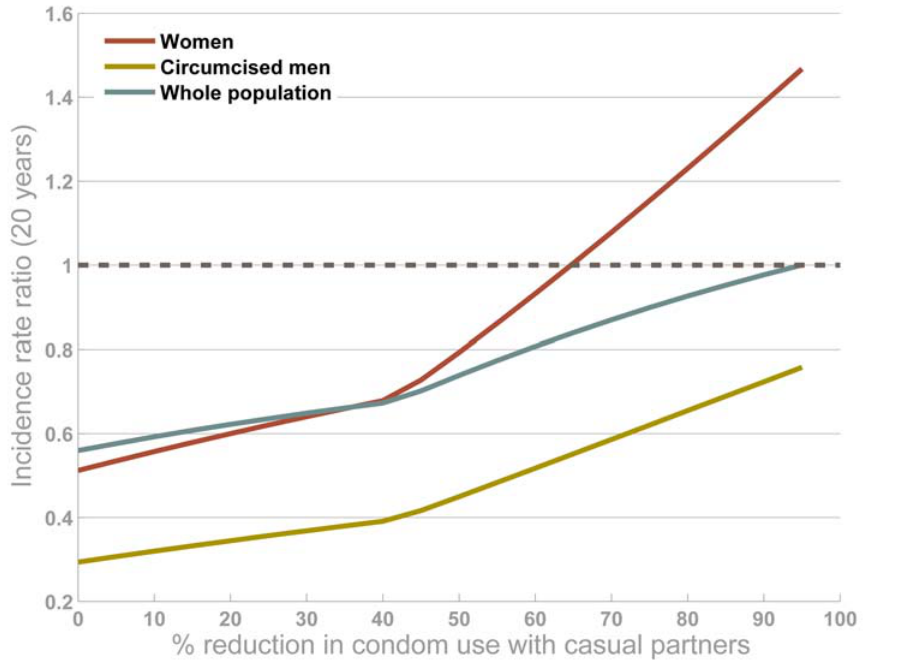
Figure 6. The impact of risk compensation by circumcised men. Men that are circumcised in the intervention are assumed to reduce the chance they use condom with casual partners (originally 0.6 [8,37]) by between 0 (no change) and 100% (no condom use at all with causal partners). The output is the ratio of HIV incidence twenty years after the intervention starts among women (red line), circumcised men (yellow line), and the population overall (blue line) when the intervention is simulated relative to the projection with no intervention. A value greater than 1 indicates that incidence is higher with the intervention. It is assumed that 90% of men are circumcised in the intervention.